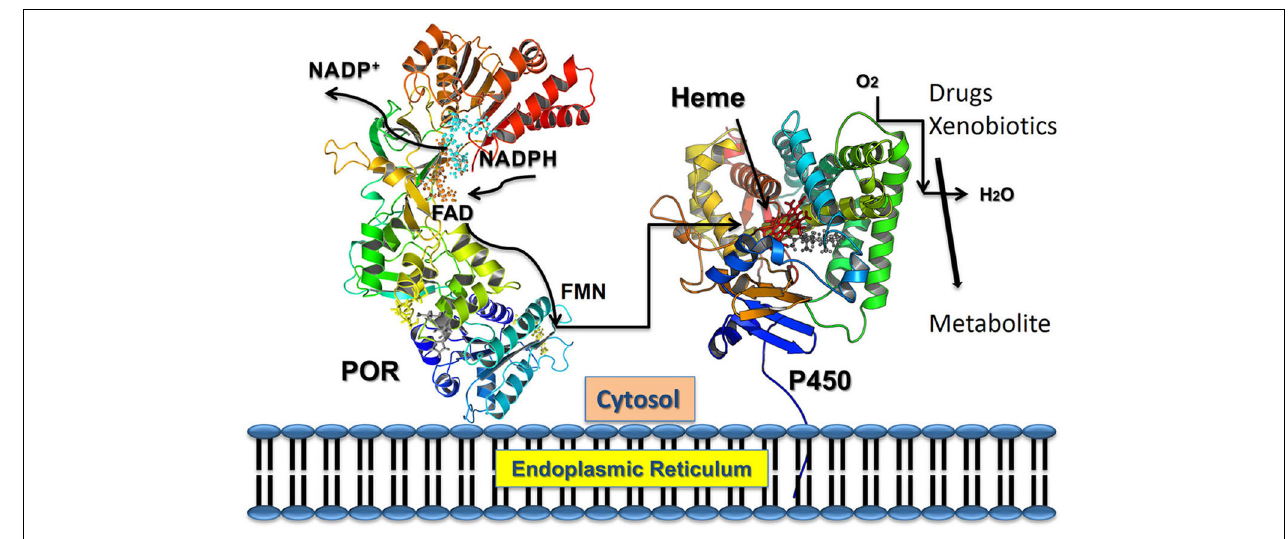
FIGURE 2 | Electron transfer from NADPH to redox partners of POR. NADPH binds to POR located into the endoplasmic reticulum, and donates electrons which are received by FAD. Electron transfer to FAD causes a conformational change that brings together the